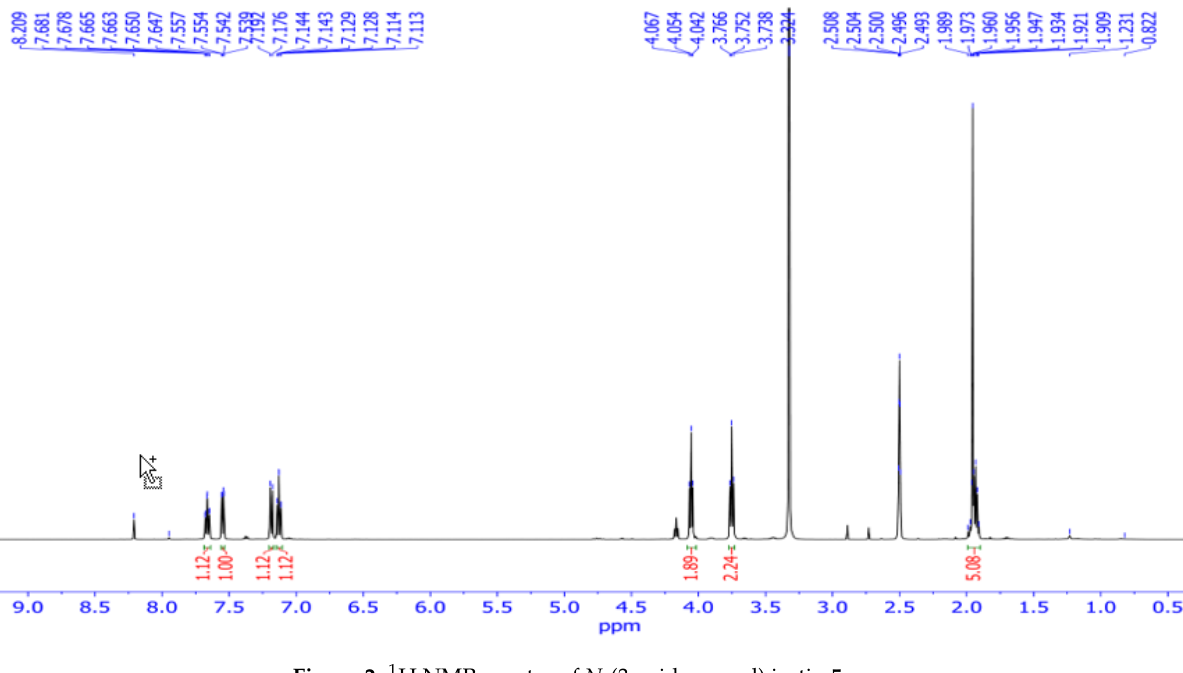
Figure 2. 1 H NMR spectra of N -(3-azidopropyl) isatin 5g .